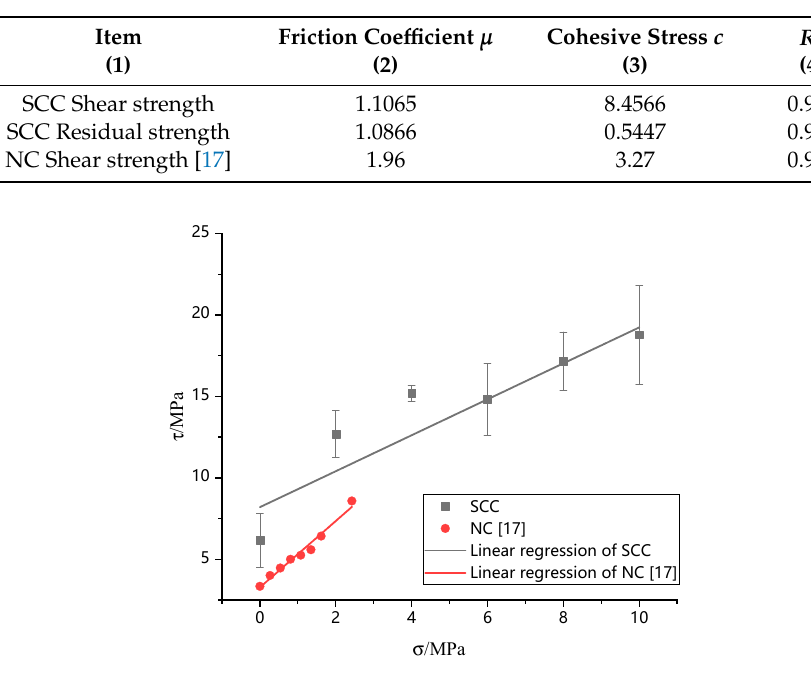
Figure 8. Relationship between axial pressure and peak shear strength.